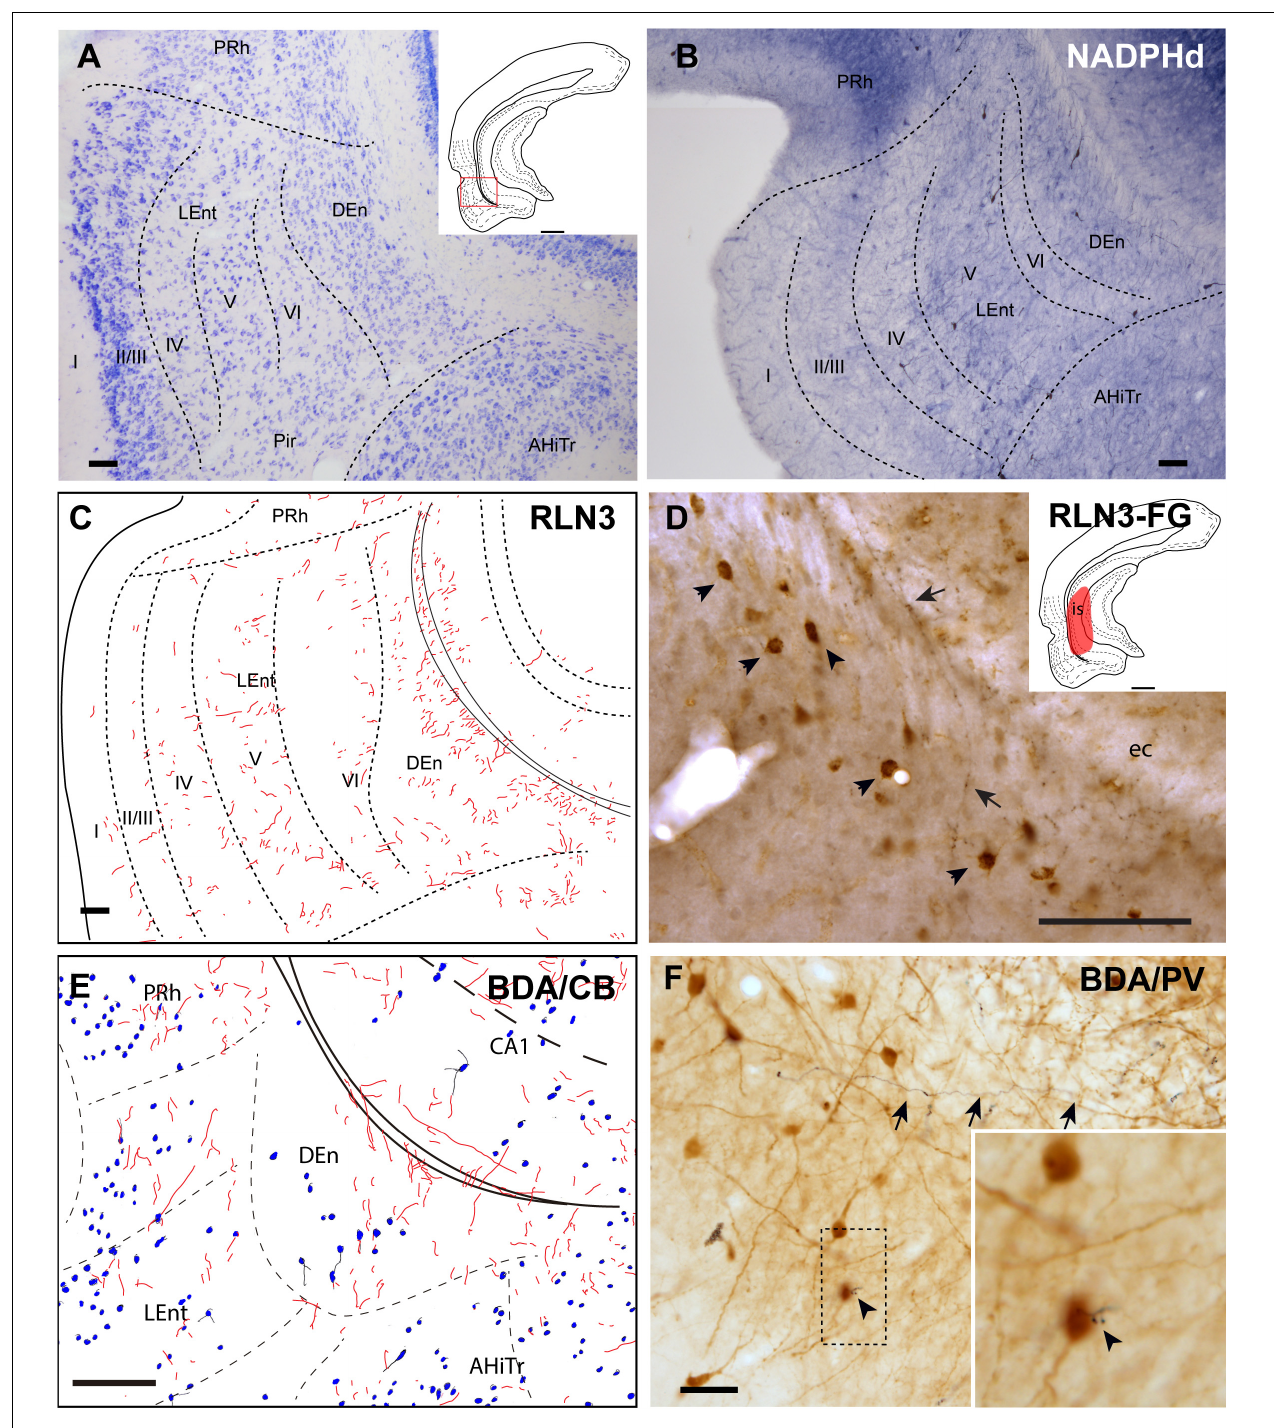
FIGURE 6 | Distribution of anterograde labeling and RLN3 staining in the dorsal endopiriform nucleus. (A) Giemsa stain of the boundaries of the DEn. (B) NADPHd histochemistry revealed an intense neuropil reaction and some accumulation of positive somata compared with deep layers of LEnt. (C) Camera lucida drawings of RLN3 fibers in case N1. (D) Photomicrograph illustrating the appearance of RLN3 labeled fibers in the DEn containing retrograde labeling (arrowheads) from FG injection in the CA1 field extending to the DG. Arrow points to a fiber crossing the external capsule (ec) to enter the hippocampus, as part of the perforant pathway in case FG32. (E) Camera lucida drawing of sections labeled for BDA injected into the NI and for CB in case FH53. (F) Photomicrograph illustrating the appearance of labeling for BDA fibers (black) and PV neurons (brown). Arrowhead points to a close apposition. Arrows point to a long fiber entering the hippocampus via the perforant pathway, case FH54. Calibration bars (A–F) 100 µ